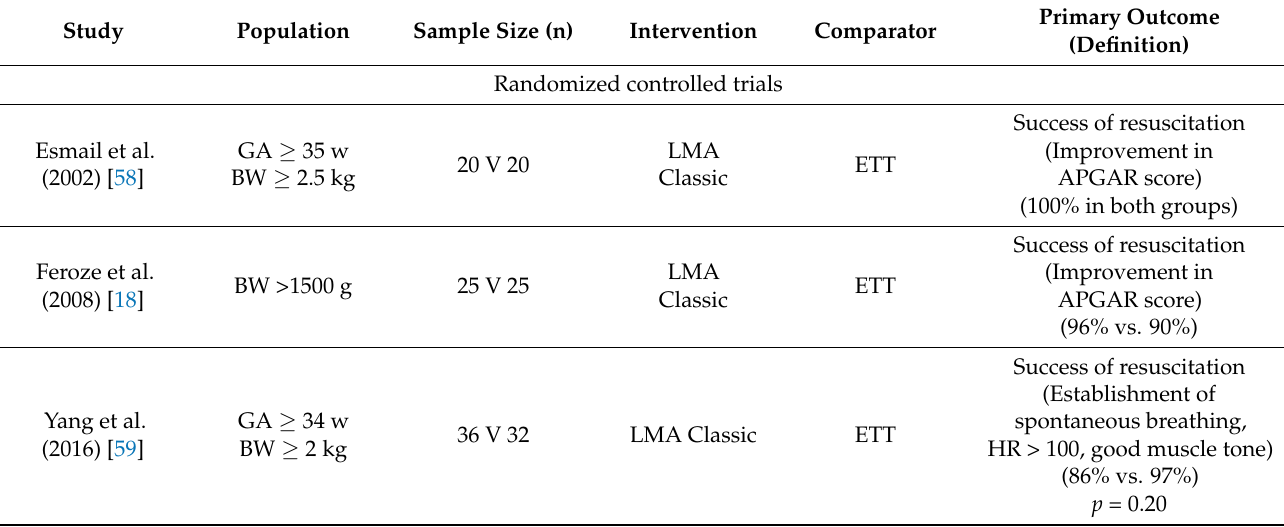
Table 2. Studies comparing LM and ETT as a secondary PPV